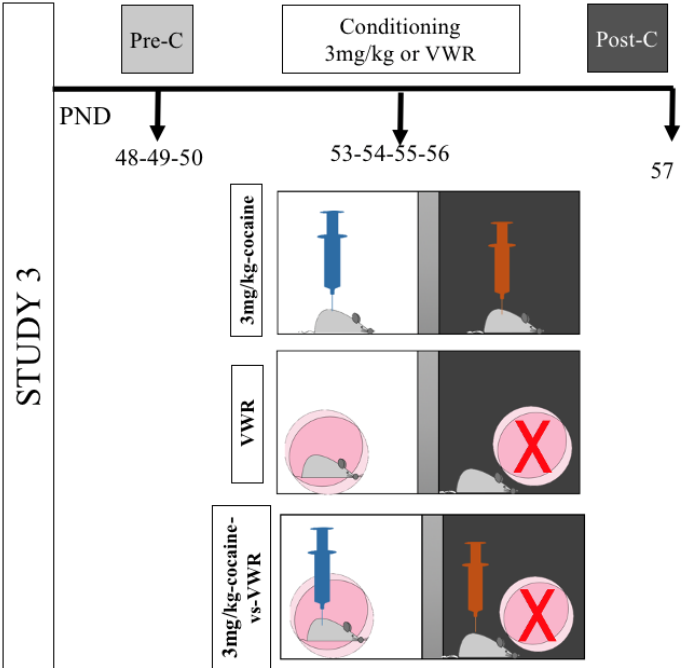
Figure 3. Experimental design and experimental groups of Study 3. In the diagram, blue syringes represent the injection of saline while orange syringes represent the injection of 3 mg/kg cocaine. Active running wheels are depicted as a pink circle while blocked wheels (inactive) are represented as a pink circle with a red “ X ” .